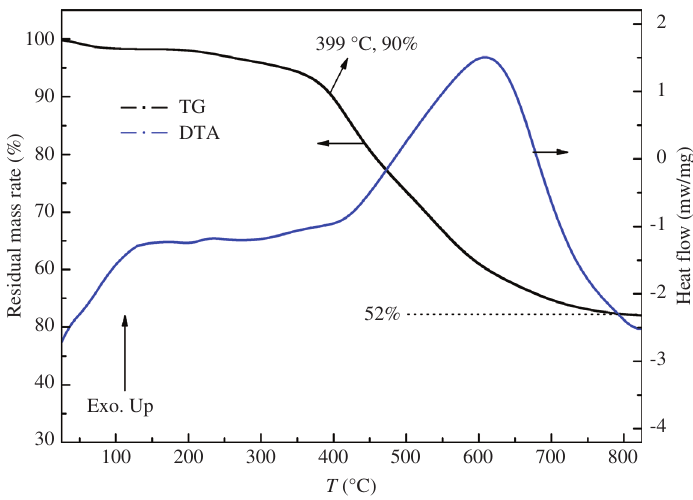
Figure 9 TG and DTA curve of phenolic resin in nitrogen after